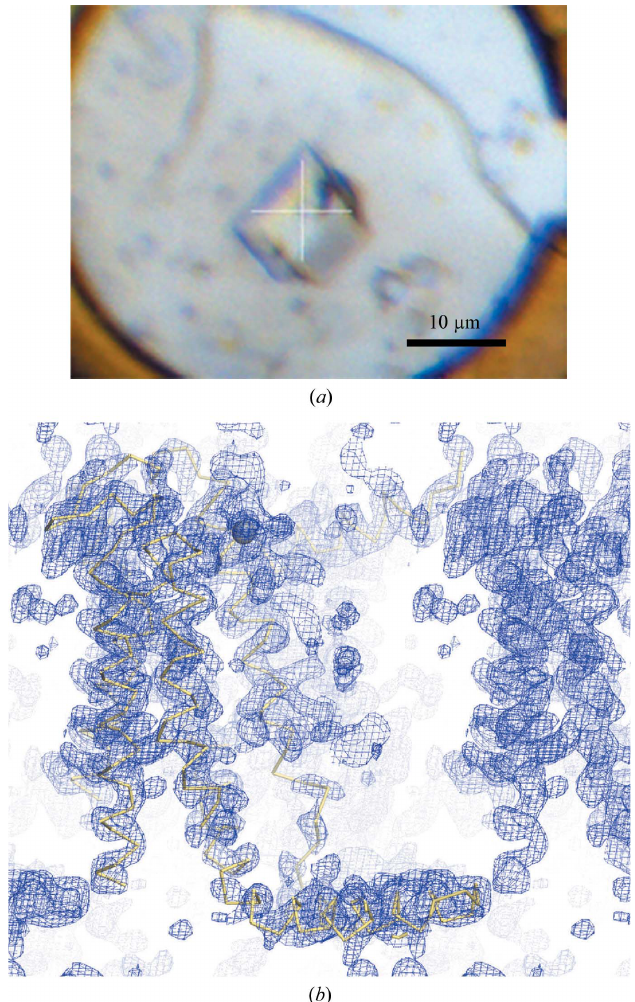
Figure 5 A single in meso microcrystal sufficient for structure solution by two- wavelength Hg-MAD at BL32XU. ( a ) A crystal of Hg-YidC. ( b ) The initial MAD-phased electron density at 1.0 (cid:3) with a backbone of the final model of YidC. This was obtained by the helical data-collection